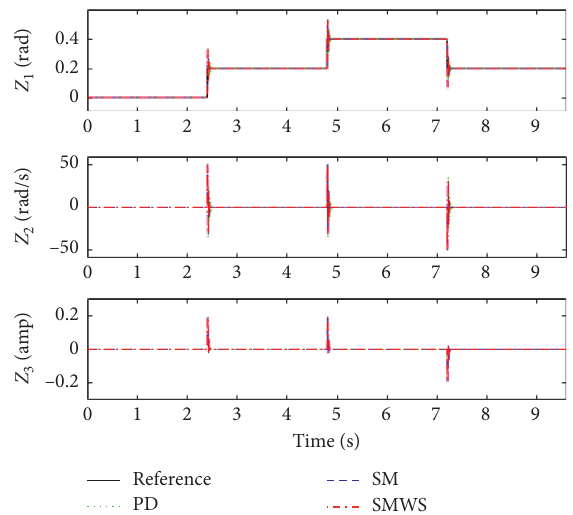
Figure 11: States of the second electricity generator.